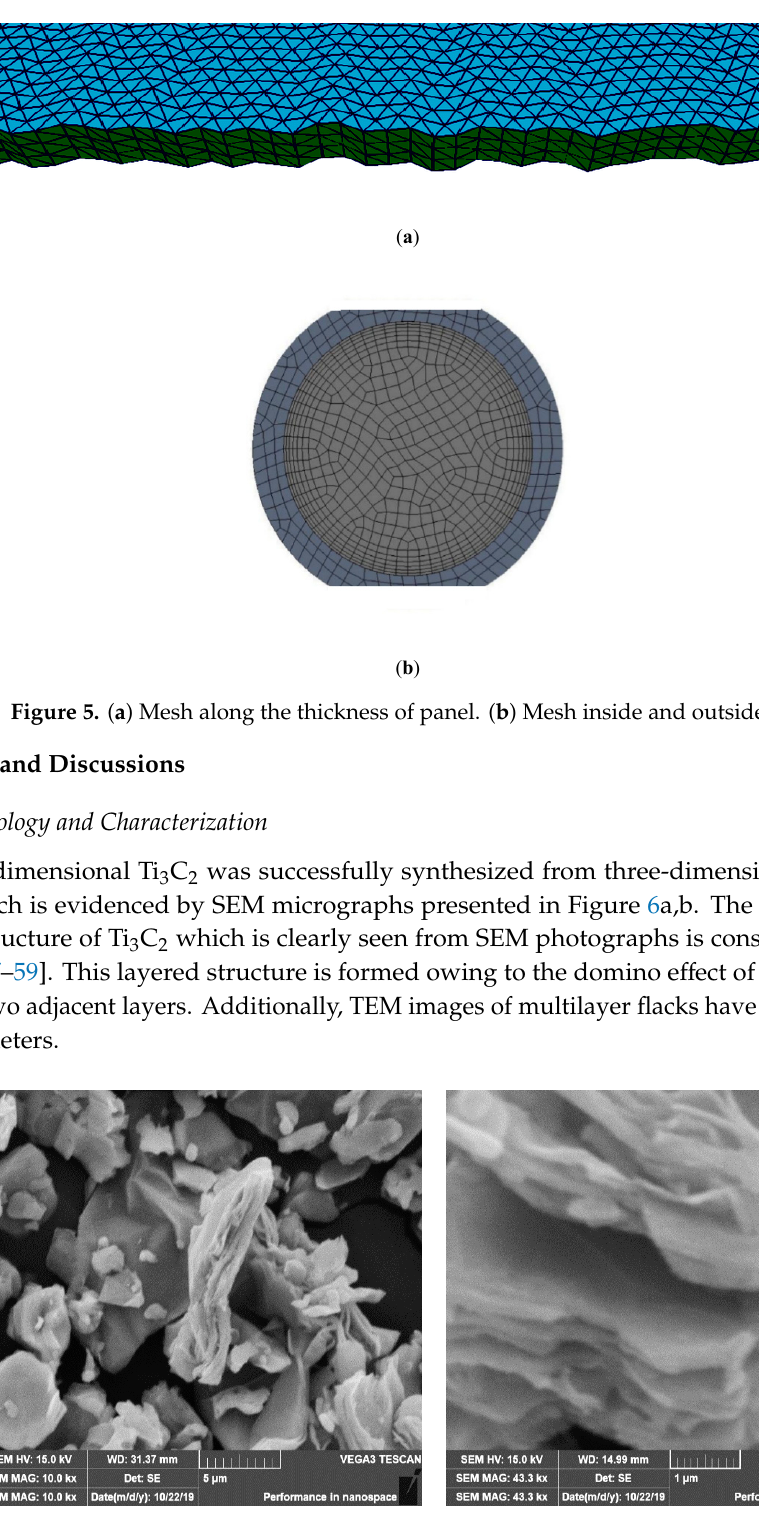
Figure 4. PV/T element with finite element meshing.